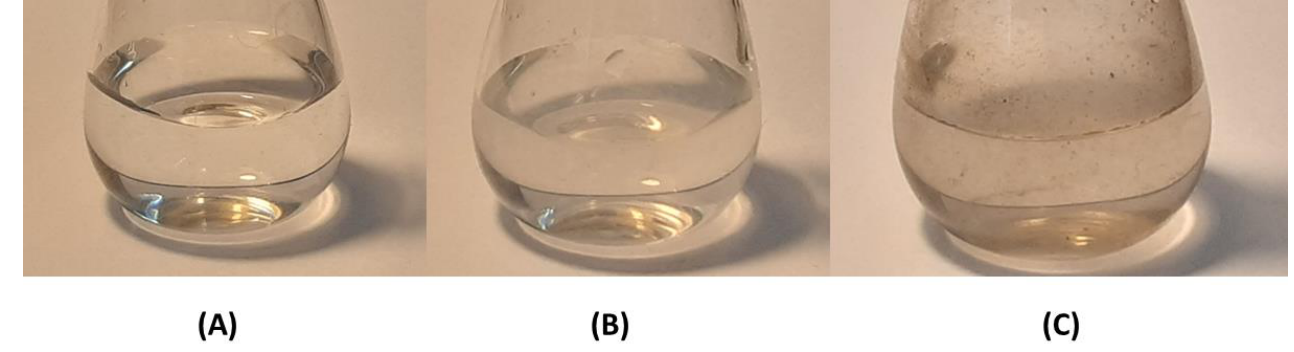
Figure 3. Eye drops solution on the first day ( A ) and 6 months after preparation, stored in a refrigerator ( B ) and at room temperature ( C ).